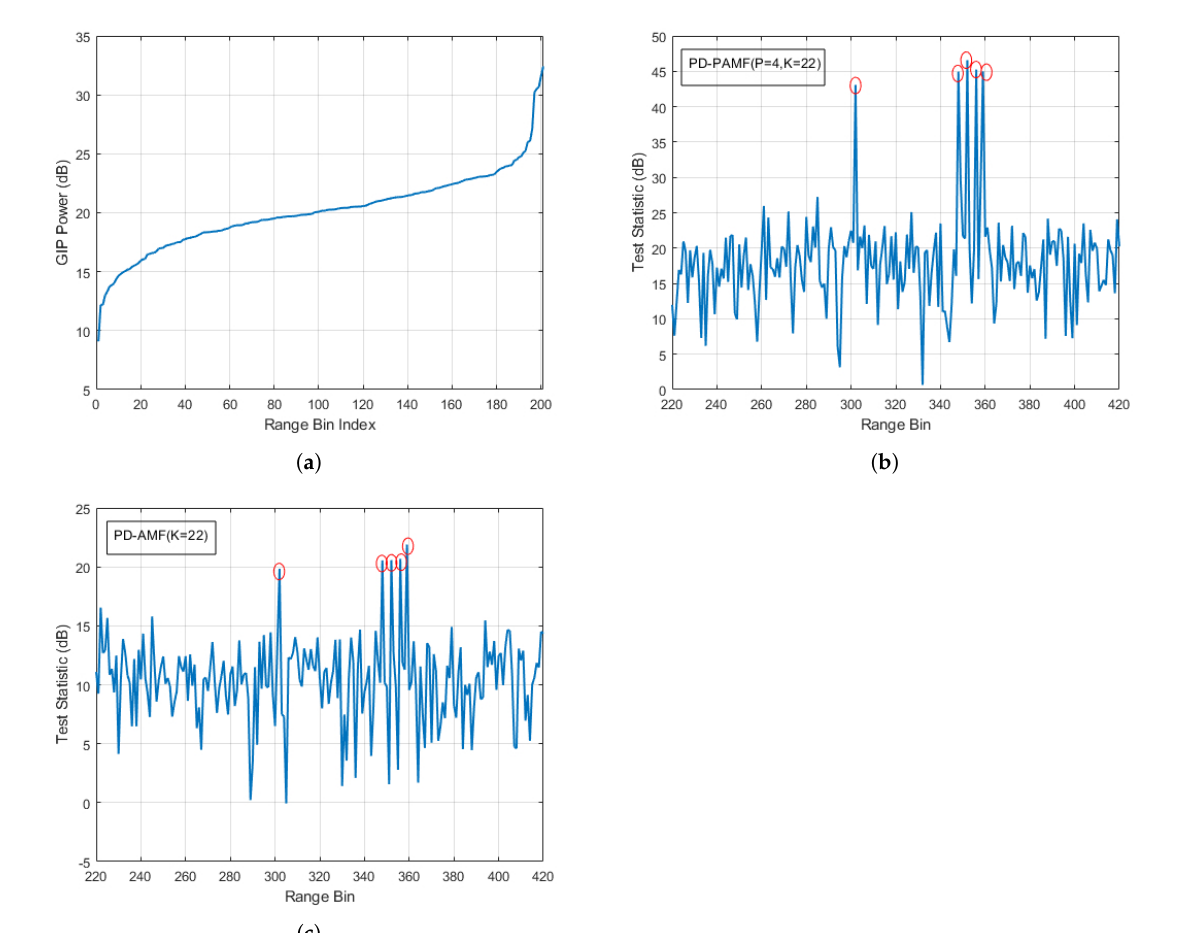
Figure 11. Detection results of the generalized inner product (GIP) with K = 2N = 22 and fixed windows and a target signal (red circle): ( a ) sorted GIP power; ( b ) PD-PAMF test statistic, AR(4), five targets in R = 302, 348, 352, 356, 356, and 359; and ( c ) PD-AMF test statistics, five targets in R = 302, 348, 352, 356, and